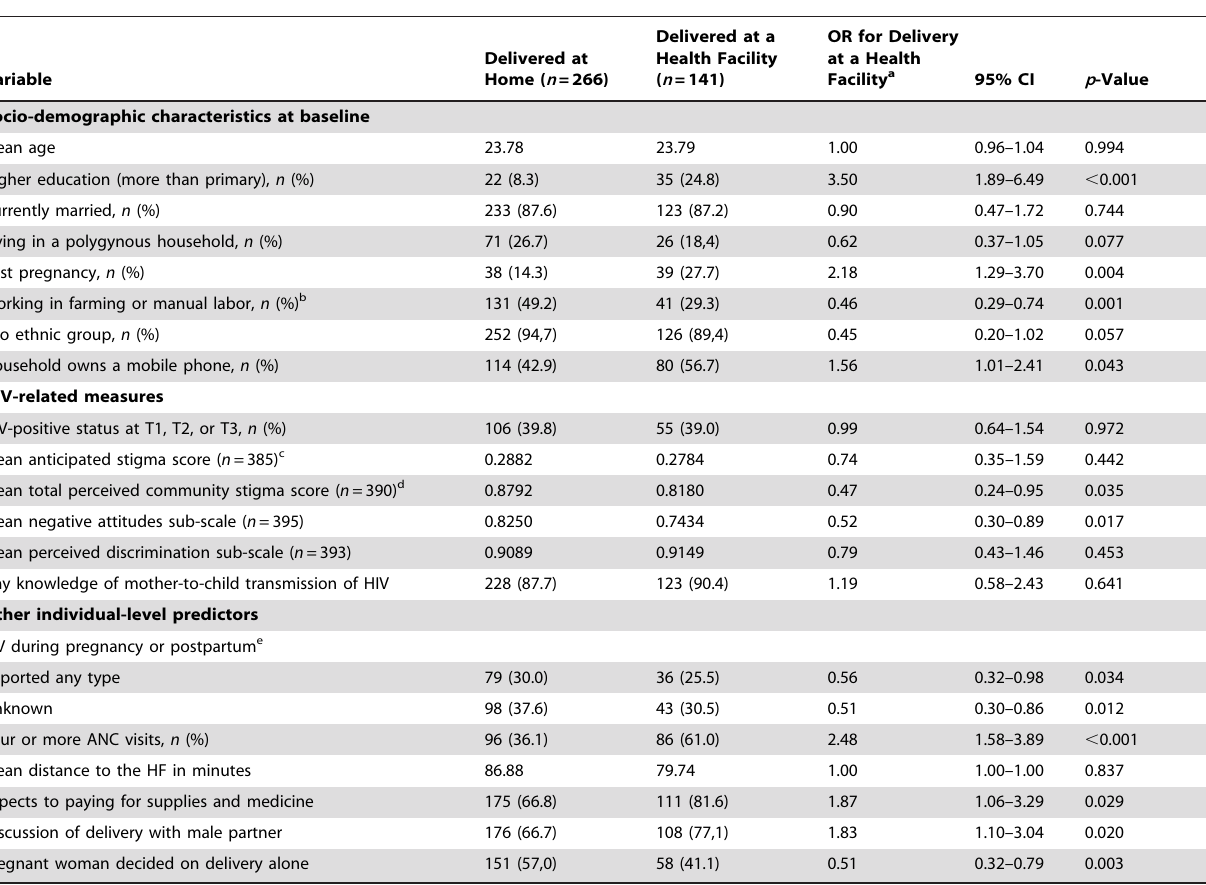
Table 3. Associations of predictor variables with place of delivery (unadjusted, accounting for clustering by site) ( n =407).